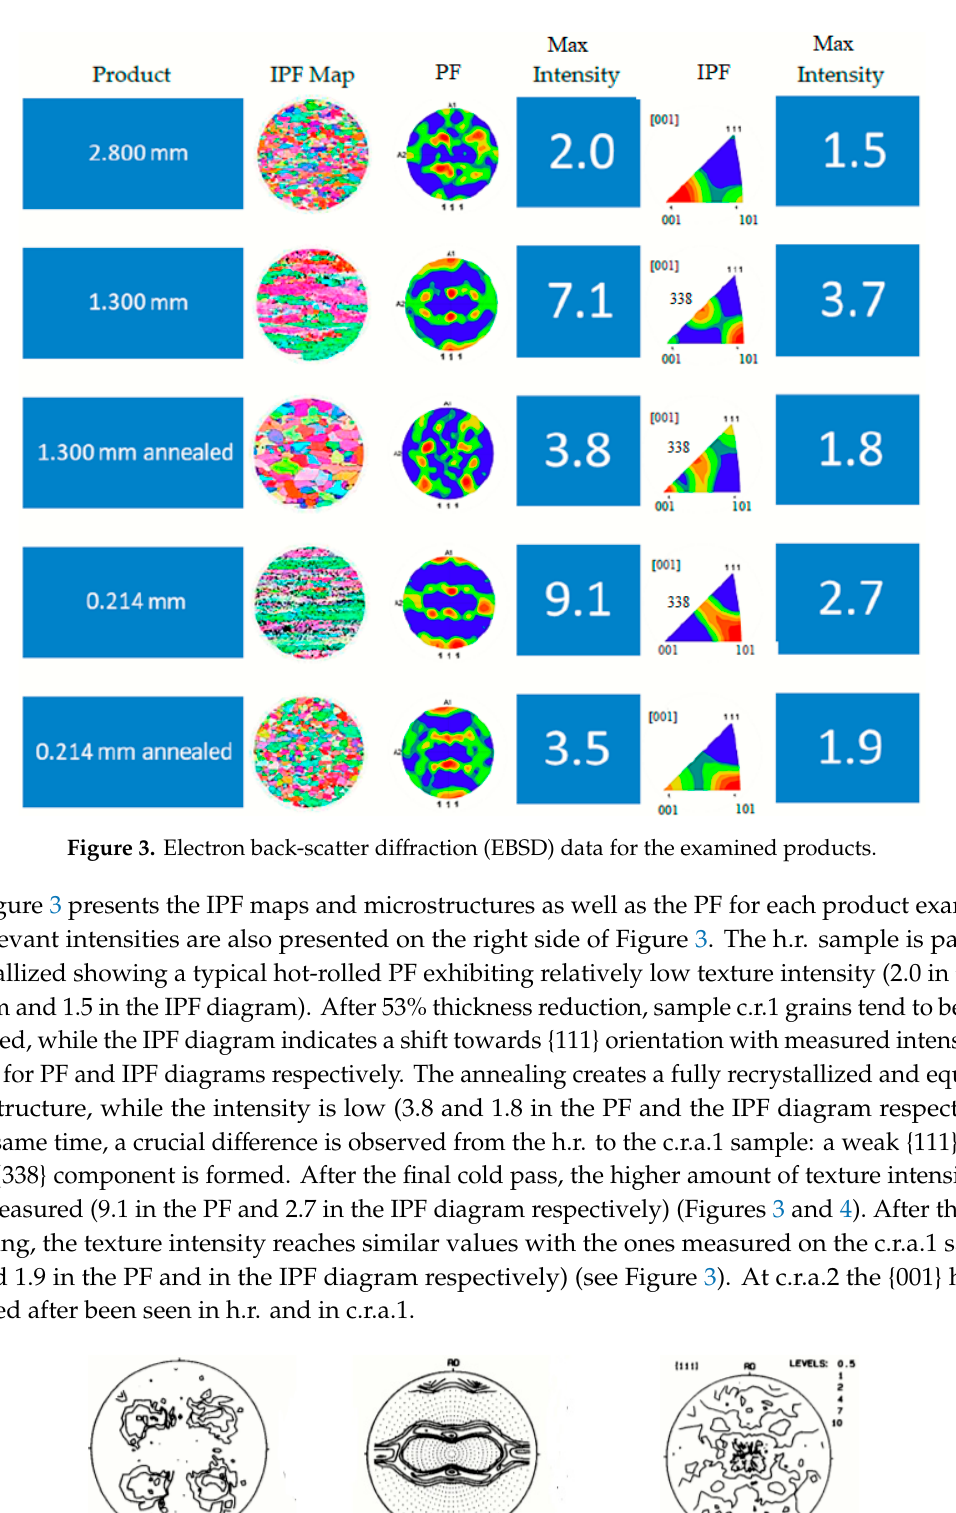
Figure 5. Texture percentage chart. The effect of annealing changed the components analogies increasing the random texture. Q, R and Goss increased leaving just a small amount of S and Taylor from the previous deformation. The final pass of 92% thickness reduction led to the formation of high amounts of S and brass, followed by Taylor and Copper. The representative recrystallization component is R. The ultimate annealing process provoked the formation of a high amount of R coexisting with brass and S (see Figure 5). Cold rolling of the h.r. sample, led to an increased amount of both rolling and recrystallization texture percentage for the c.r.1 and c.r.2 samples. It also led to increased anisotropy (see the increased intensities PF and IPF diagrams). Annealing treatment formed low PF and IPF intensities, which resemble to the original h.r. sample observed intensities. The random texture of both annealed sheet samples increased significantly reinforcing the isotropic behavior of these materials with approximately 1% normal anisotropy. This could be explained by the fact that in c.r.a.1 the nucleation of the cube component was inadequate (r-CubeRD) and the amount of recrystallization texture was higher than the remaining deformation texture. In contrast the c.r.a.2 exhibited greater volume fractions of the cube and R components, which favor the earing formation of 0/90° ears. In both cases the recrystallization texture in the annealed samples is higher than the cold-rolled samples before. EBSD findings are analytically presented in the following chart, where the exact percentages of the random, recrystallization (Rex) and rolling texture are shown for each examined case (Figure 5).